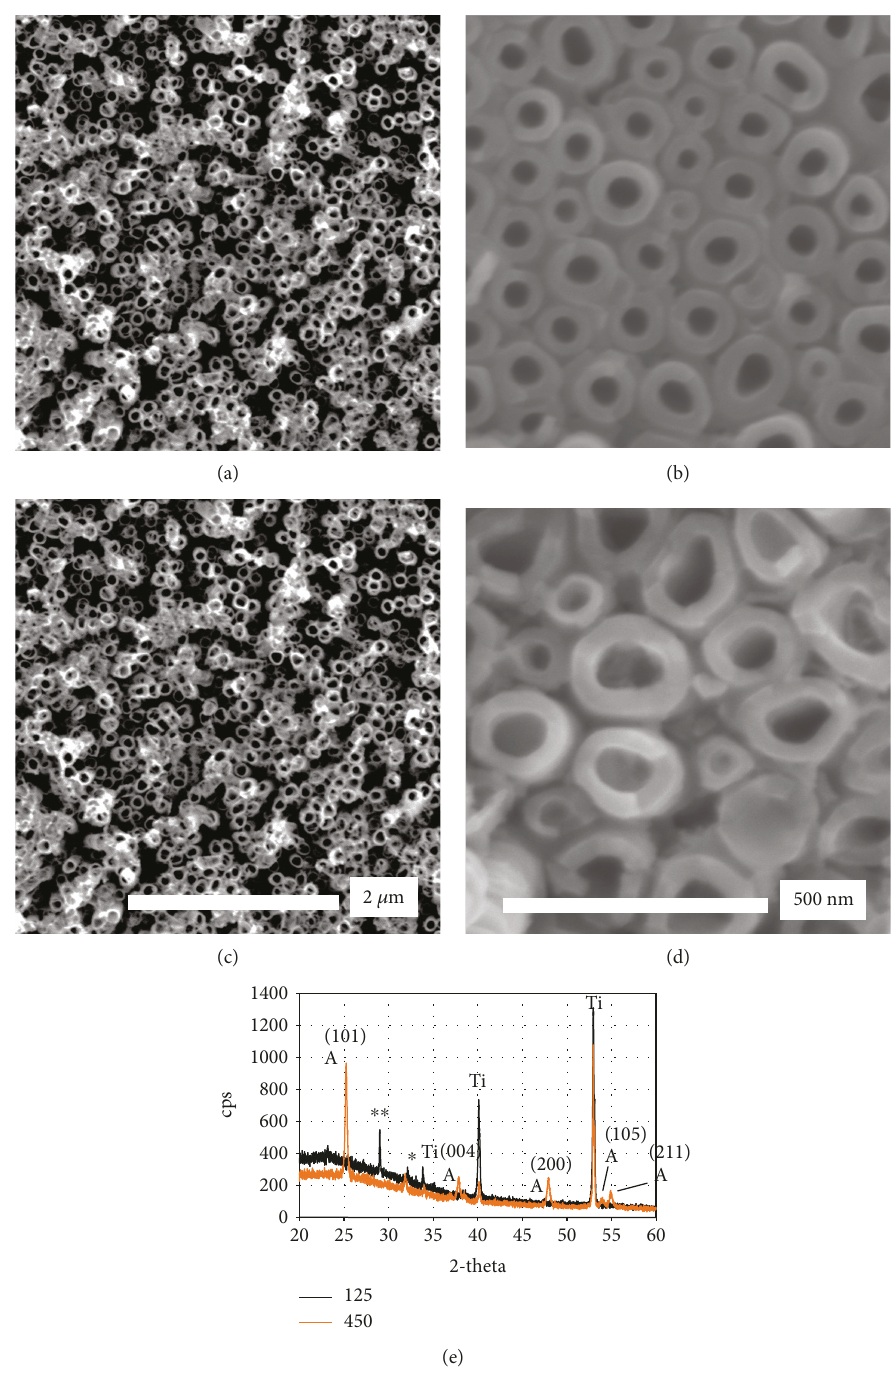
Figure 1: Scanning electron microscope images of 40V RT grown nanotubes annealed at (a, b) 125 ° C and (c, d) 450 ° C. The 2 μ m scale bar is for (a, c) while the 500nm scale bar is for (b, d). (e) X-ray di ff raction patterns of the samples. ∗∗ indicates possible presence of carbon impurities after 125 ° C heating, while ∗ is a possible other titanium oxide